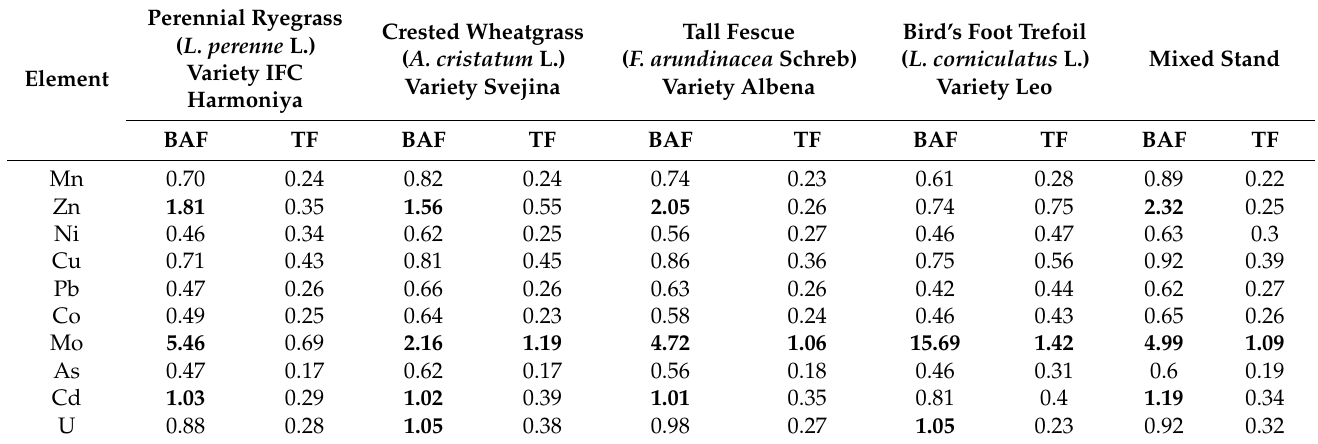
Table 6. Bioaccumulation and translocation of PTEs in studied experimental variants (BAF and TF values above 1 are shown in bold